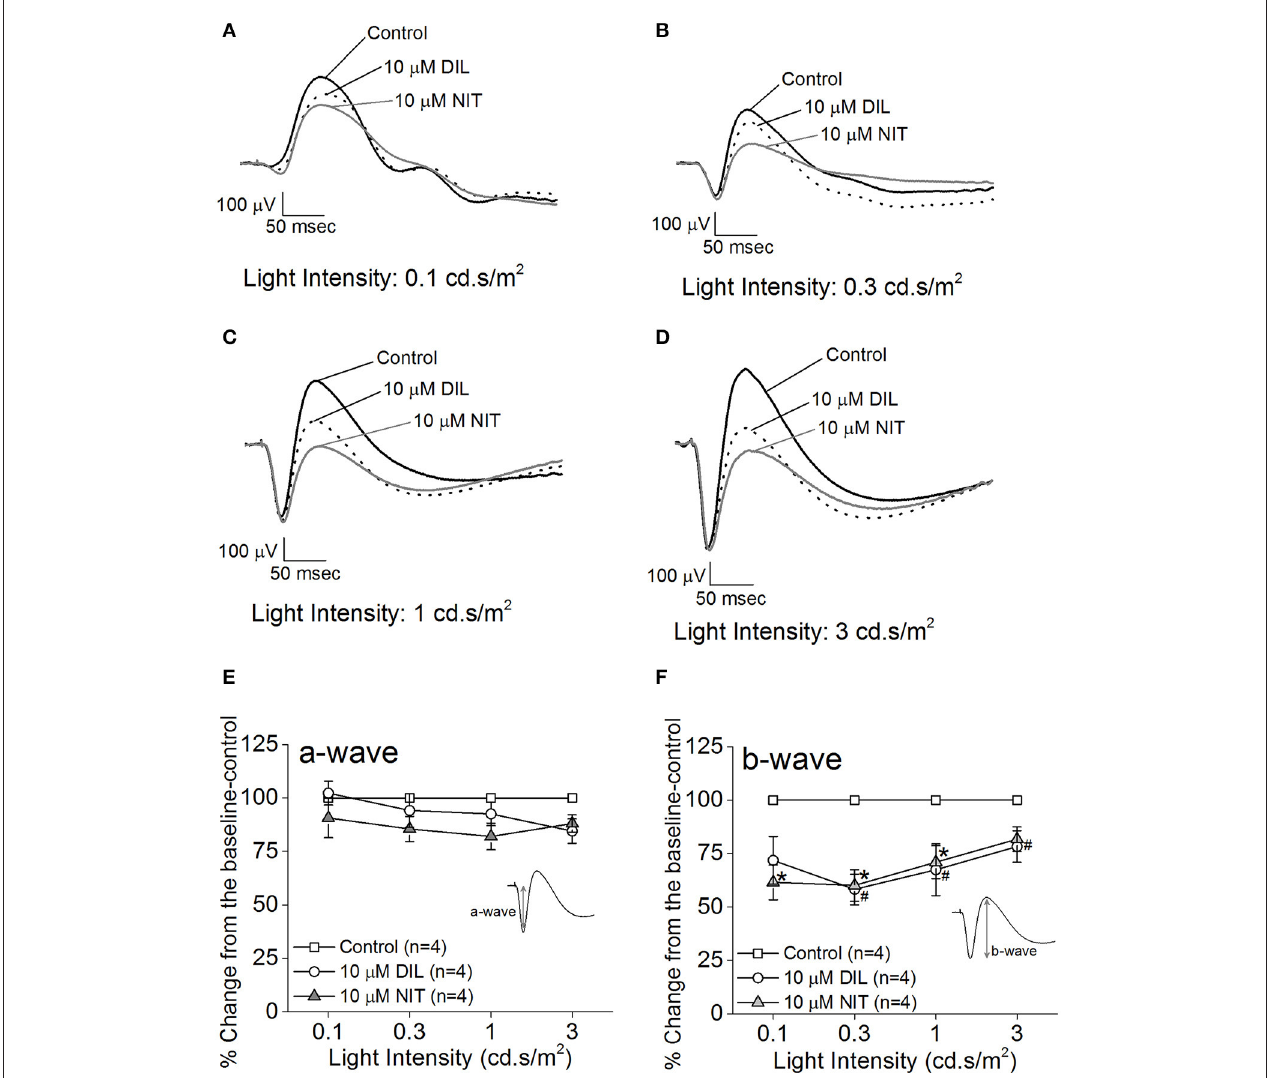
FIGURE 2 | Differential contributions of LTCCs to retinal light responses as measured by ex vivo ERGs . Mice were dark adapted for at least 3h, and the retinas were excised and placed in an ex vivo ERG recording chamber. The ERG responses were recorded under 4 different light intensities: 0.1, 0.3, 1, and 3 cd · s/m 2 . The ERG recordings were performed with normal perfusion buffer (Control), followed by perfusion with 10 µ M DIL to inhibit Ca v 1.2, and subsequently perfused with 10 µ M nitrendipine (NIT) to block both Ca v 1.2 and Ca v 1.3. (A–D) Representative ERG waveforms recorded in different solutions (control, 10 µ M DIL, and 10 µ M NIT) are shown, which were recorded under light intensities of 0.1, 0.3, 1, and 3 cd · s/m 2 , respectively. (E) Perfusion with 10 µ M DIL or 10 µ M NIT for 10min did not have significant effect on the ERG a-wave amplitudes. (F) Perfusion with 10 µ M DIL or 10 µ M NIT for 10min decreased ERG b-wave amplitudes. The asterisk (*) indicates a statistically significant difference between the control and the 10 µ M NIT group; “ # ” indicates that the 10 µ M DIL group is statistically different from the control. * , # p < 0.05.